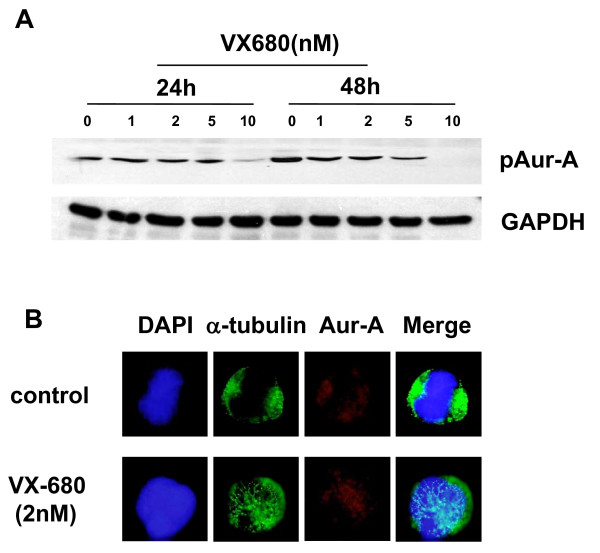
VX-680 inhibits activation of Aur-A and induces monopolar spindle in NB4-R2 cells. (A) VX-680 inhibited phosphorylation of Aur-A at Thr288 in NB4-R2 cell line. Cells were incubated with increasing doses of VX-680 for 24 hr and 48 hr and subjeceted to Western blot with antibodies of pAur-A and GAPDH. (B) The morphology of mitotic spindle was shown by immunofluorescence staining with anti-α-tubulin antibody and anti-Aur-A antibodies. Microtubules were stained as green, Aur-A protein as red, and nucleus as blue.